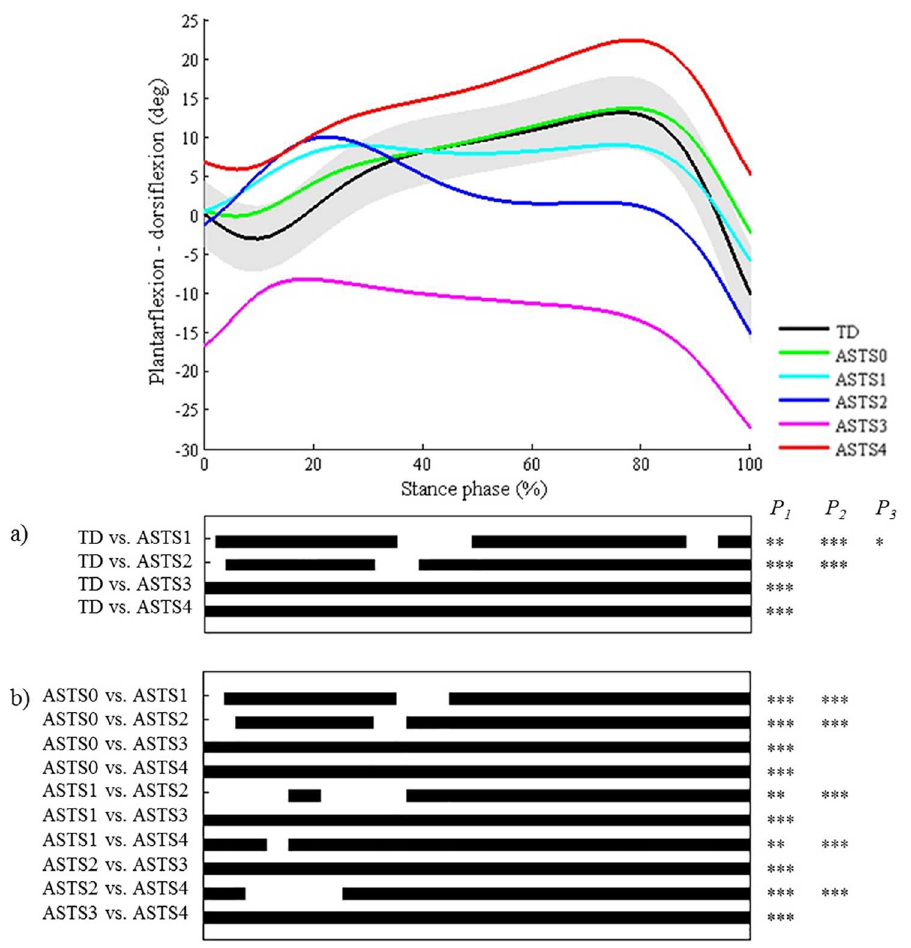
Fig 11. Ankle during stance in the sagittal plane (ASTS). Top graph shows the mean kinematicangle of TD gait and of each consensus-based pattern of the ankle duringstance in the sagittal plane. Black bars indicatesignificantgait phases duringwhich the SPM{t} statistic exceededthe critical threshold.Panel ( a ) shows results of hypothesis 2 (i.e. unpairedt-tests, α = 0.01); panel ( b ) shows results of hypothesis3 (i.e. post-hoc unpairedt-tests, α = 0.001). * p < 0.01, ** p < 0.001, *** p < 0.00001. P 1 indicatesthe p-value of the first cluster duringthe stance phase, P 2 the second cluster,